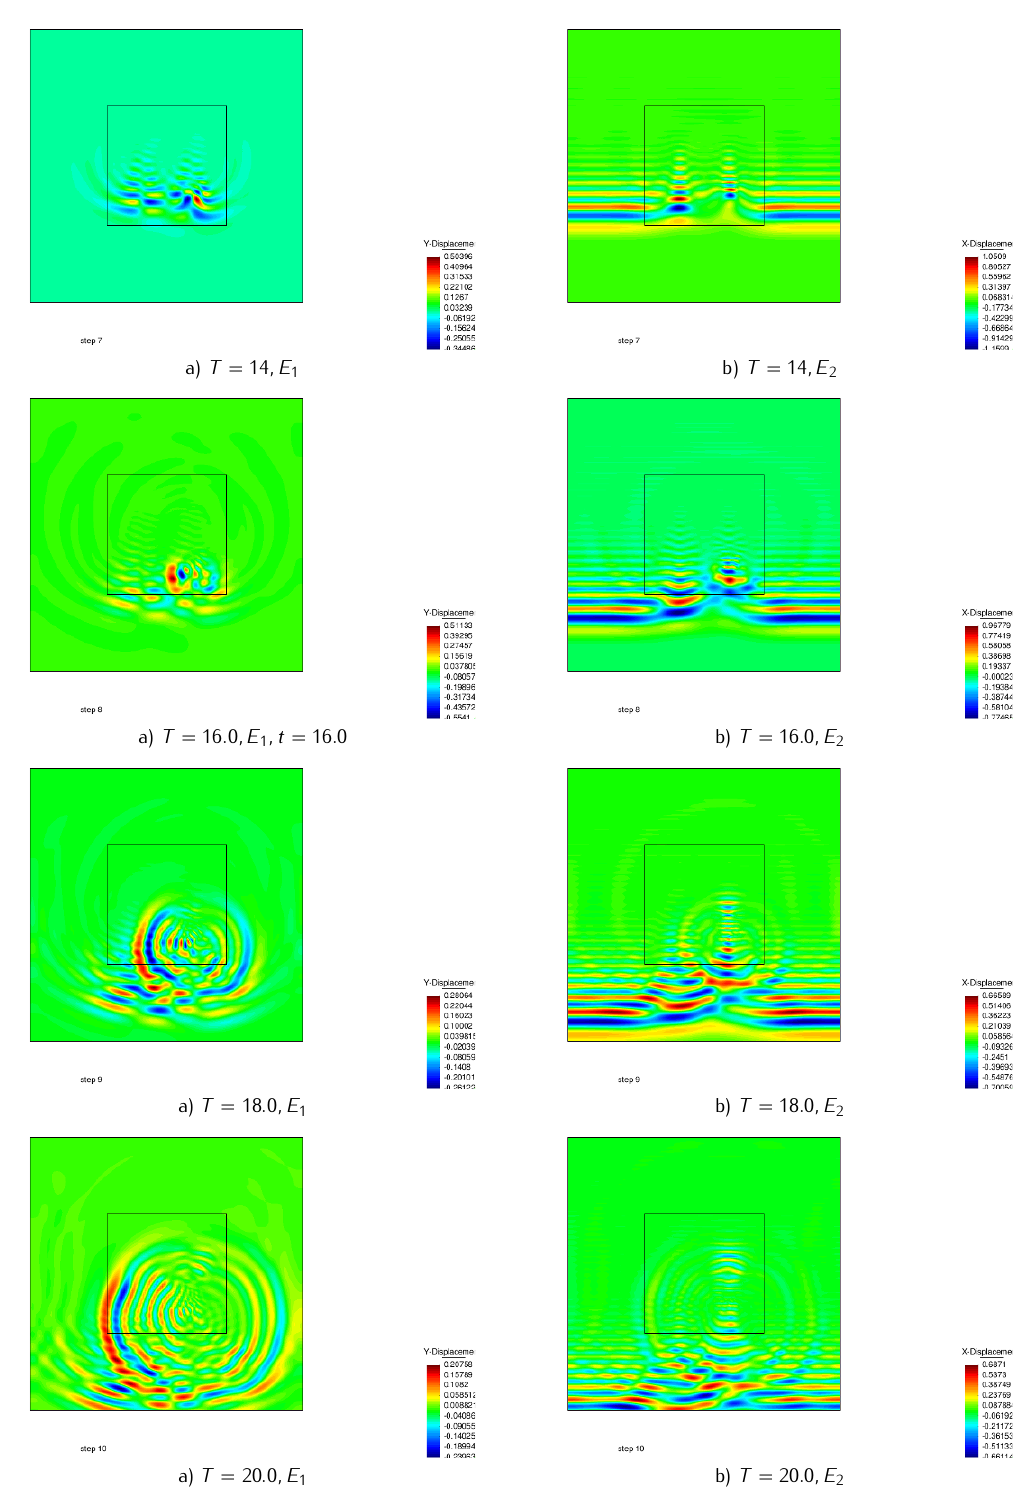
Figure 17. Test 4. Computed components of the electric field E h = ( E 1 h ,E 2 h ) at different times in Ω using the domain decomposition FEM/FDM. The coefficient ε ( x ) in Ω is defined by (53) FEM